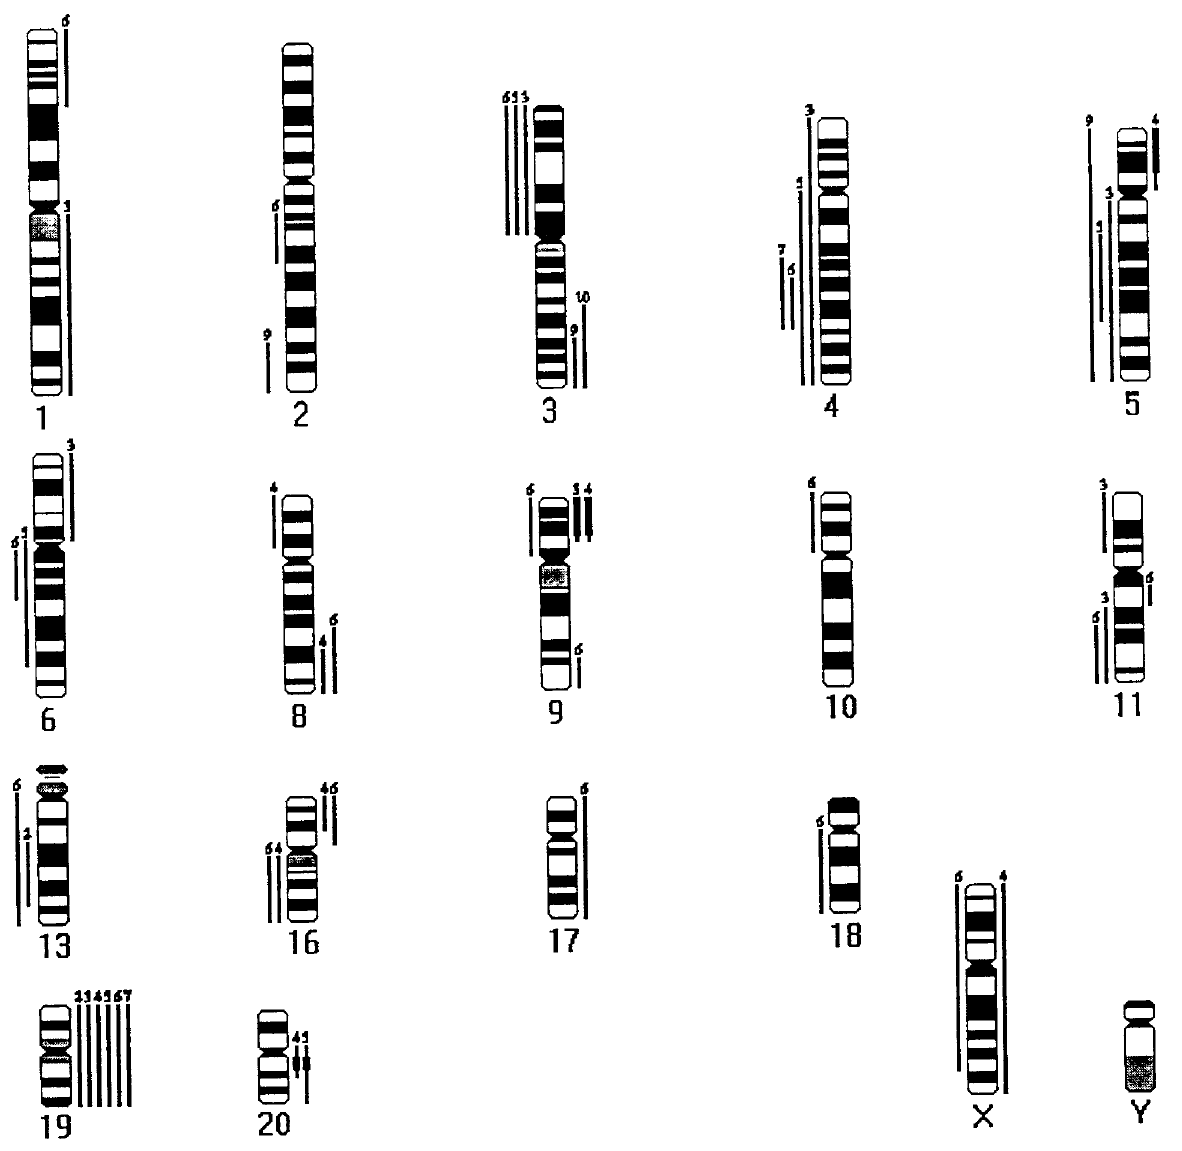
Fig. 1. Summary of DNA gains and losses detected by comparative genomic hybridization in cervical squamous cell carcinomas (stage Ib). Each chromosome is schematically depicted with areas of DNA loss represented by bars to the left and areas of DNA gain represented by bars to the right of the chromosome ideogram. Thick bars represent areas of high-level DNA